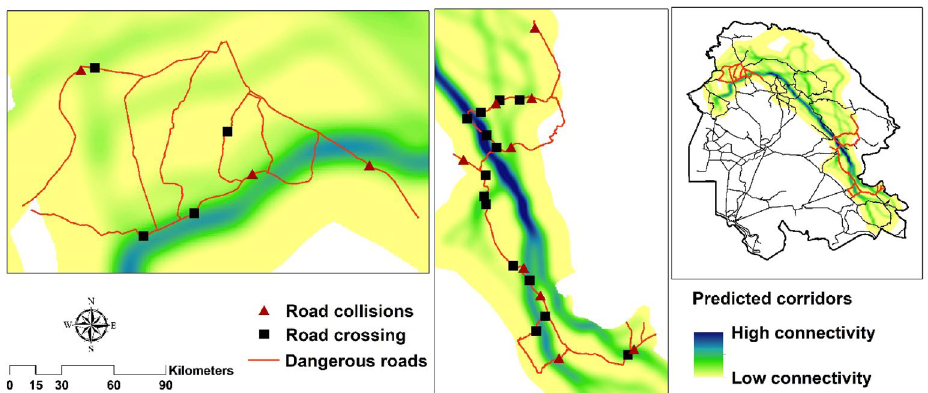
Figure 5. Predicted corridors, striped hyaena road observations (18 crossing + 12 collisions, data collected during 2015–2020) and roads in the study area. ArcGIS software version 10.1 (https:// www. esri. com/ en- us/ arcgis/ produ cts/ arcgis- pro/ resou rces) and UNICOR software version 1.0 (https:// www. fs. usda. gov/ trees earch/ pubs/ 40686) were used to generate the figure.